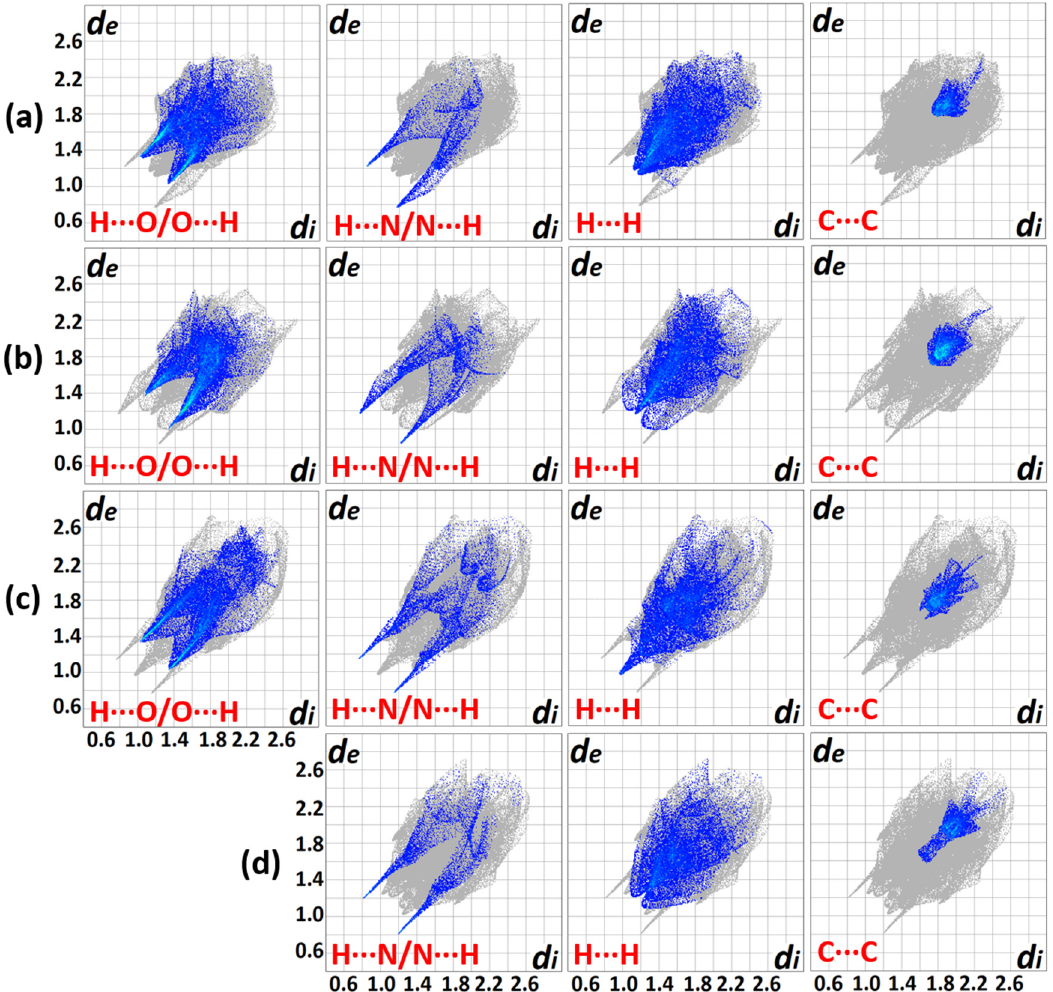
Figure 7. Comparison of 2D fingerprint plots for the compounds ( a ) IA, ( b ) IB, ( c ) II and ( d ) III (Erroneous H ··· O / O ··· H plot (disordered O atoms of NO 2 ) was omitted) with the depicted non-covalent interactions (d i and d e represent the internal and external distances (Å) away from a point on the Hirshfeld map, respectively) .